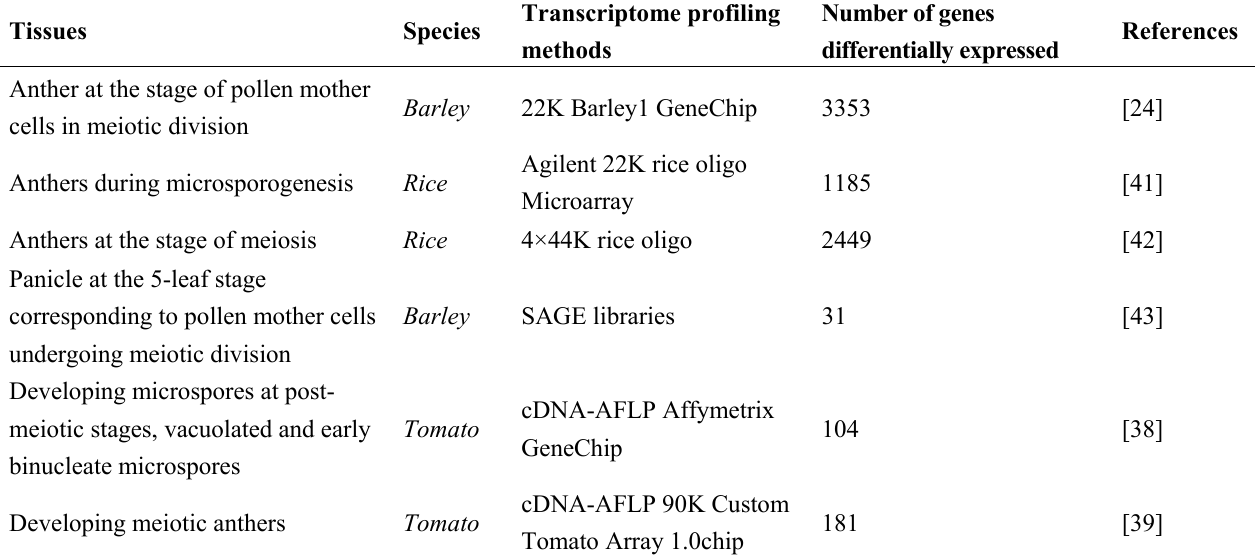
Table 1. Survey of gene expression experiments performed with male reproductive organs under